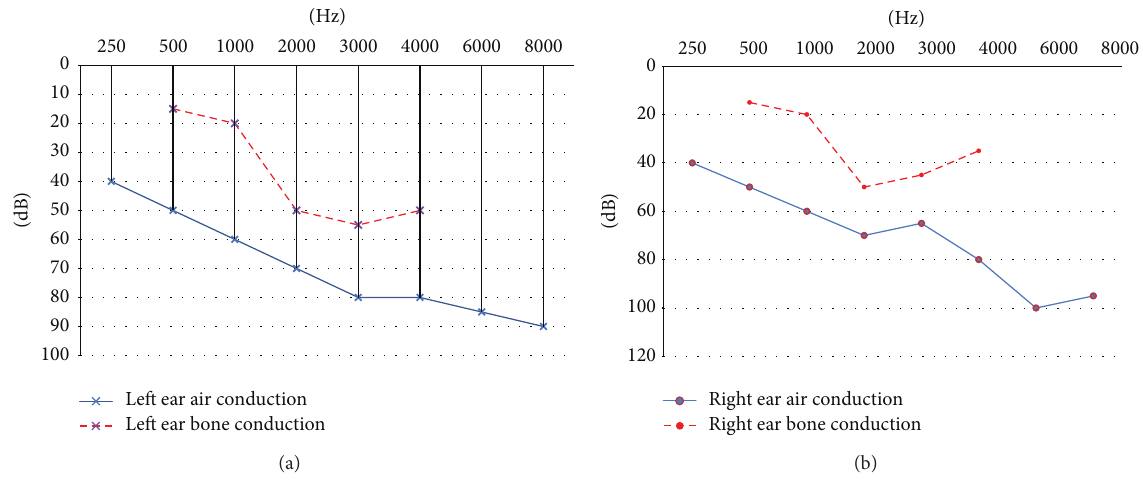
Figure 1: Presenting bilateral mixed hearing loss (full description in the text).